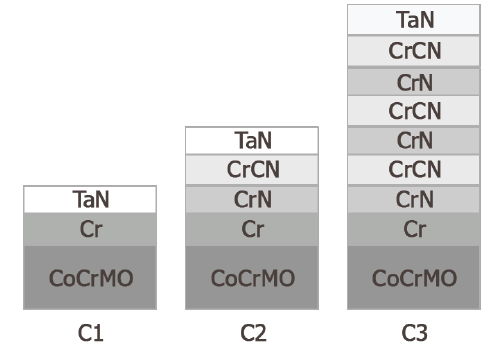
Figure 1: Coating architectures of the samples illustrated in